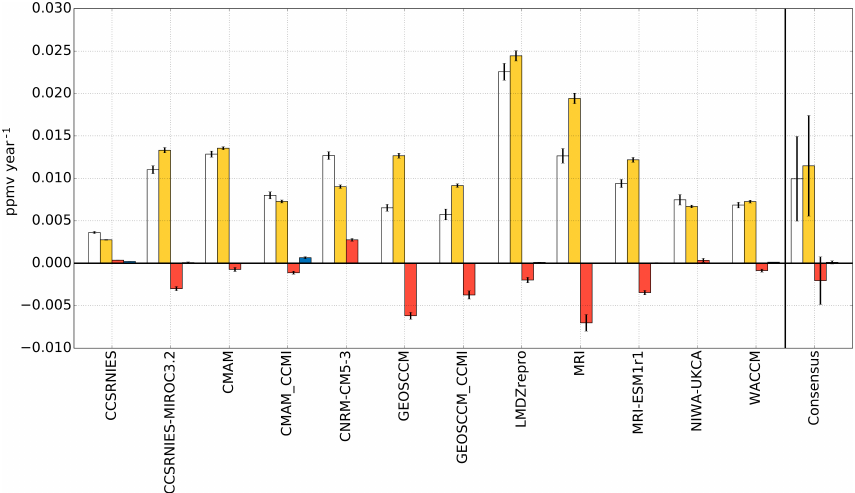
Figure 4. Trends in [ H 2 O ] entry (white) resulting from (cid:49)T (yellow), BDC (red), and QBO (blue) predictor time series assuming the other predictors are held constant. Error bars represent 95% uncertainty. For many models, the contribution of the QBO is too small to be